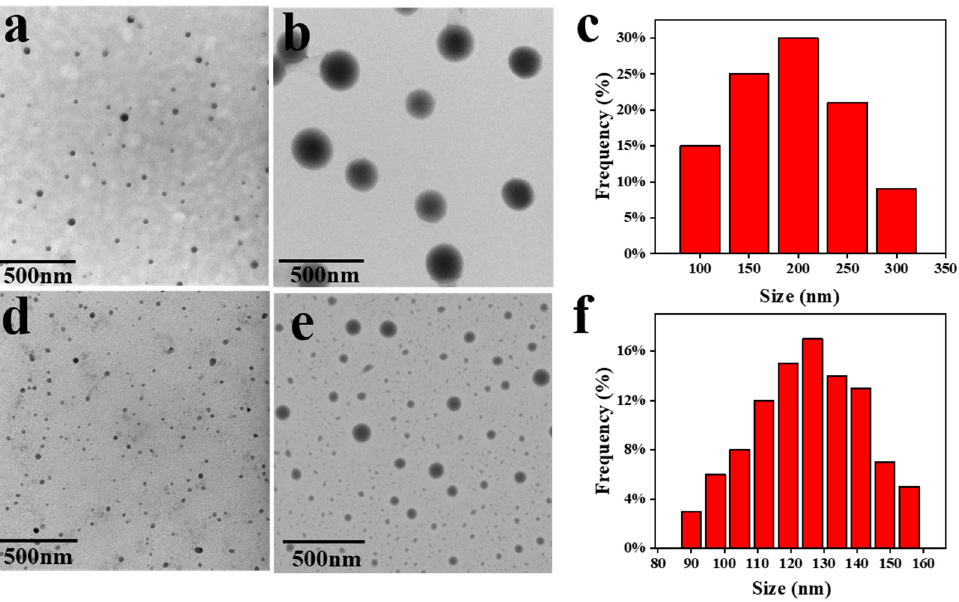
Figure 2. TEM images of ECA and TCA samples prepared according to Table 1. ( a ) Sample A, ( b ) sample B, ( d ) sample C, ( e ) sample D. ( c ) Size distribution of sample B by DLS and ( f ) Size distribution of sample D by DLS.